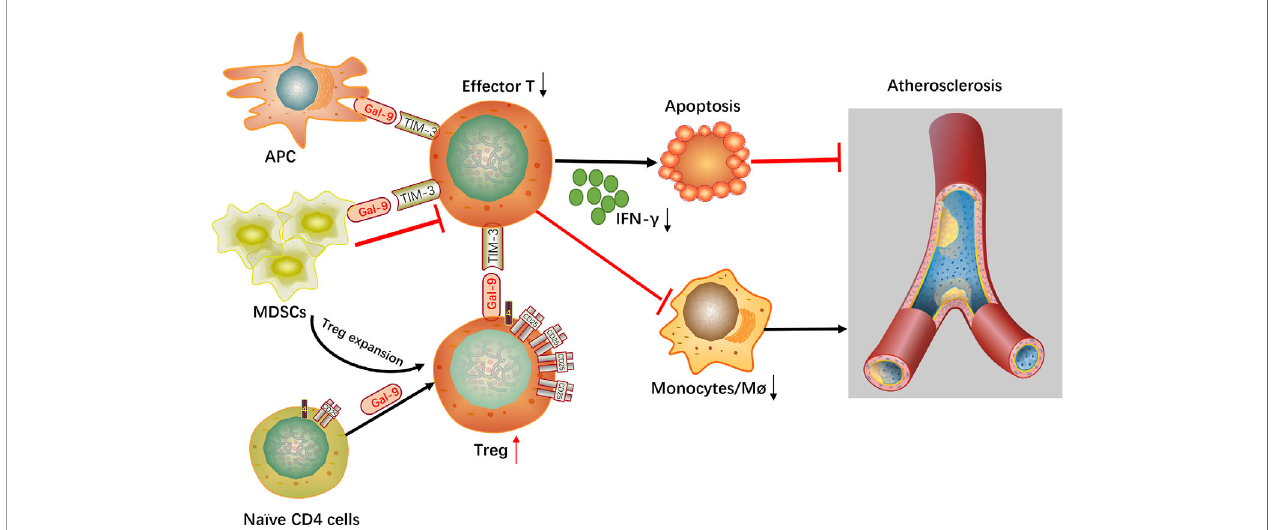
FIGURE 2 | Mechanistic summary. Gal-9, galectin-9; Tim-3, T-cell immunoglobulin mucin 3; Effector T, effector T cells; Treg, regulatory T cell; Mø, macrophages; APC, antigen-presenting cell; MDSCs, myeloid-derived suppressor